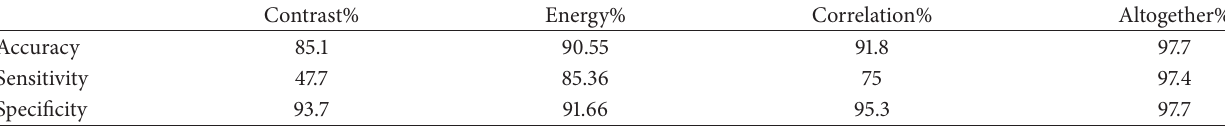
Table 5: Comparison of individual texture based features in terms of accuracy, sensitivity, and specificity.